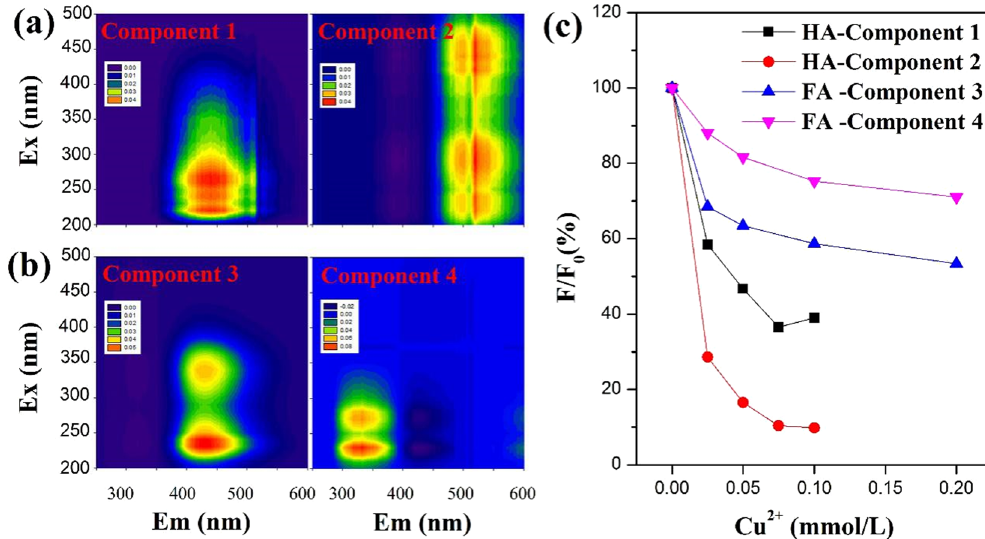
Figure 2. ( a ) PARAFAC-derived component of HA; ( b ) PARAFAC-derived component of FA; and ( c ) Fluorescence quenching of four PARAFAC-derived components with the addition of Cu 2 + . F/F0 means the ratio of fluorescence intensity with Cu 2 + addition to the initial fluorescence intensity.